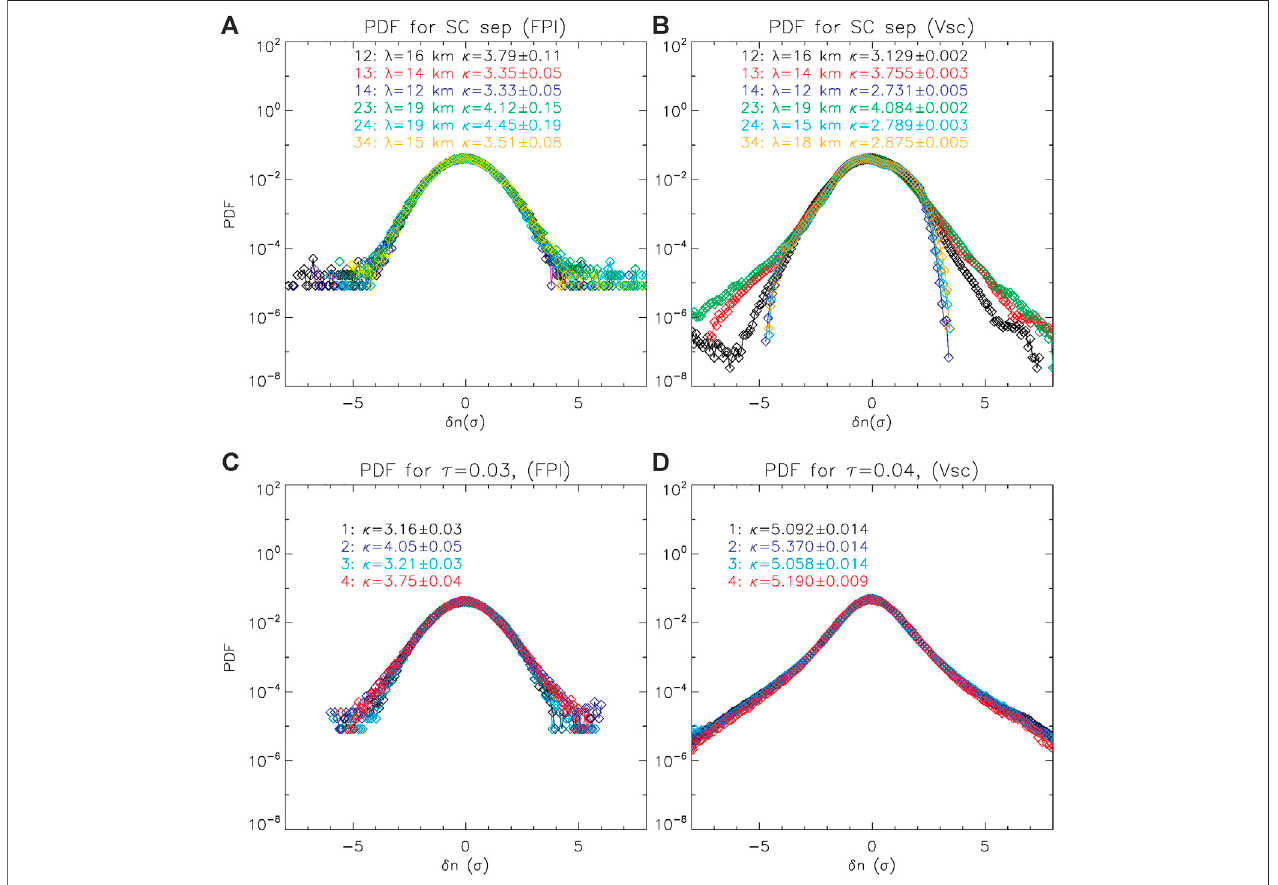
FIGURE 5 | Probability distribution functions for standardized density fl uctuations based on spatially lagged measurements from FPI-DES (A) from spacecraft potential (B) and for time lags at a comparable scale to the spatial lags for FPI (C) and for the spacecraft potential (D) .